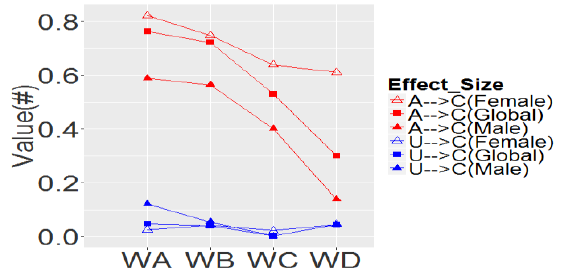
Fig. 7. Effect sizes of driver constructs on